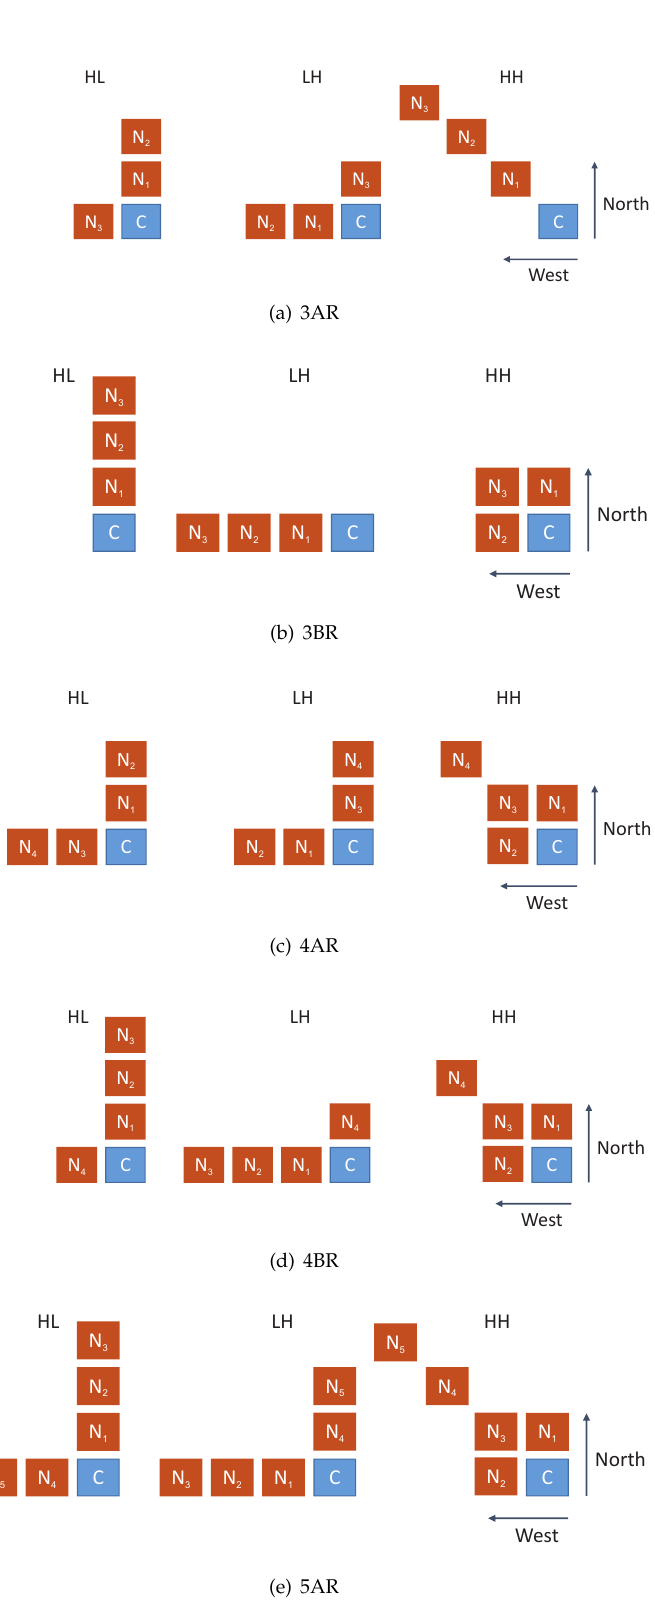
Figure 2. Set of potential Neighborhoods for a particular wavelet-based codec. C is the current wavelet coefficient and N i are its neighbors, where 3AR ( a ) and 3BR ( b ) use three neighbors, 4AR ( c ) and 4BR ( d ) use four neighbors, and 5AR ( e ) uses five neighbors for the sign prediction of C wavelet